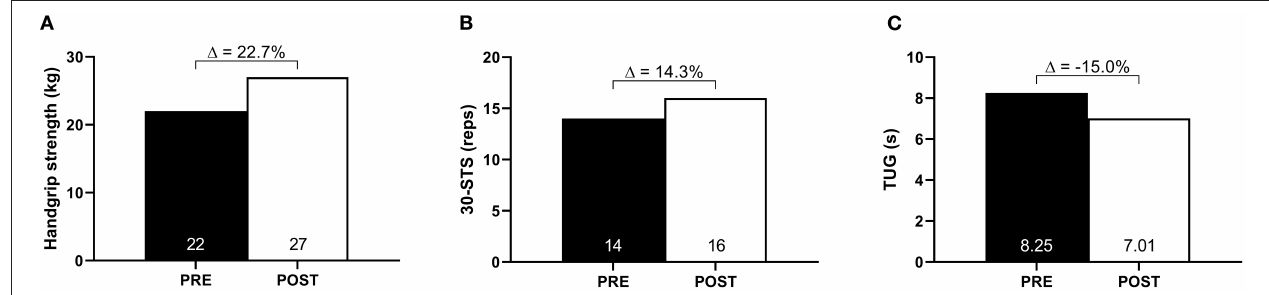
FIGURE 2 | Muscle strength and functionality at baseline (PRE) and after 10-week of HBET (POST). (A) Handgrip strength; (B) 30-s sit-to-stand (30-STS); (C) timed-up-and-go (TUG).